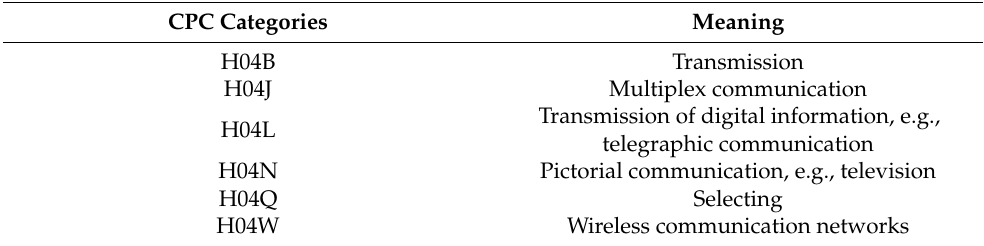
Table A1. Definition of CPC